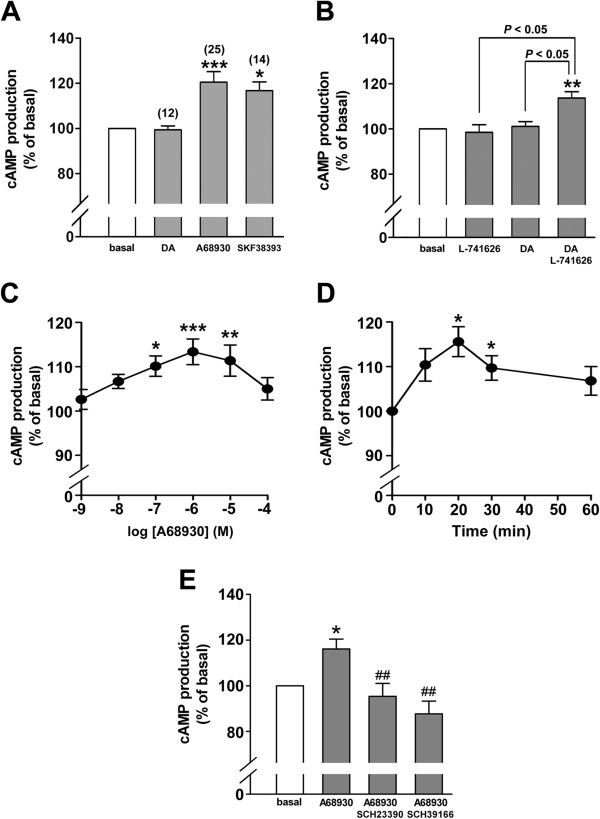
Dopamine D1 receptor agonist-induced cAMP activity in human airway smooth muscle cells. (A) The effects of dopamine (DA; 1 μM) or the dopamine D1-like receptor agonists (A68930 or SKF38393; 1 μM respectively) on cAMP production in cultured HASM cells. Number of experiments was shown in parentheses. (B) The effects of dopamine (1 μM) on cAMP production in the presence or absence of the dopamine D2 receptor antagonist (L-741626; 1 μM for 30 min pretreatment before dopamine treatment). N = 4. (C) Concentration-dependent effect of dopamine D1-like receptor agonist A68930 (1 nM - 100 μM) on cAMP production in cultured HASM cells. The cells were incubated with A68930 for 20 min before cAMP assay. N = 4 - 13. (D) Time-course effect of A68930 (1 μM) on cAMP production in cultured human airway smooth muscle cells. N = 6. (E) The effect of dopamine D1-like receptor selective antagonists SCH23390 or SCH39166 on A68930-stimulated cAMP production in HASM cells. Cells were pretreated with SCH23390 (1 μM) or SCH39166 (1 μM) for 30 min pretreatment prior to A68930 (1 μM) treatment for 20 min. Data represent means ± SEM. N = 7 - 9. *P < 0.05, **P < 0.01 and ***P < 0.001 compared with basal. ##P < 0.01 compared with A68930 alone. In each experiment, values were determined in triplicate.